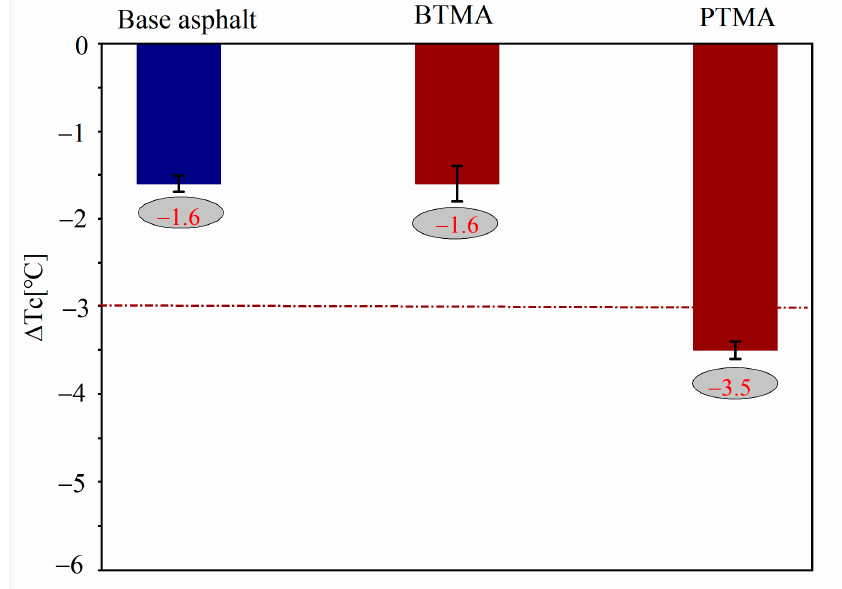
Figure 12. ∆𝑇𝑐 for all binders. Figure 12. ∆ Tc for all